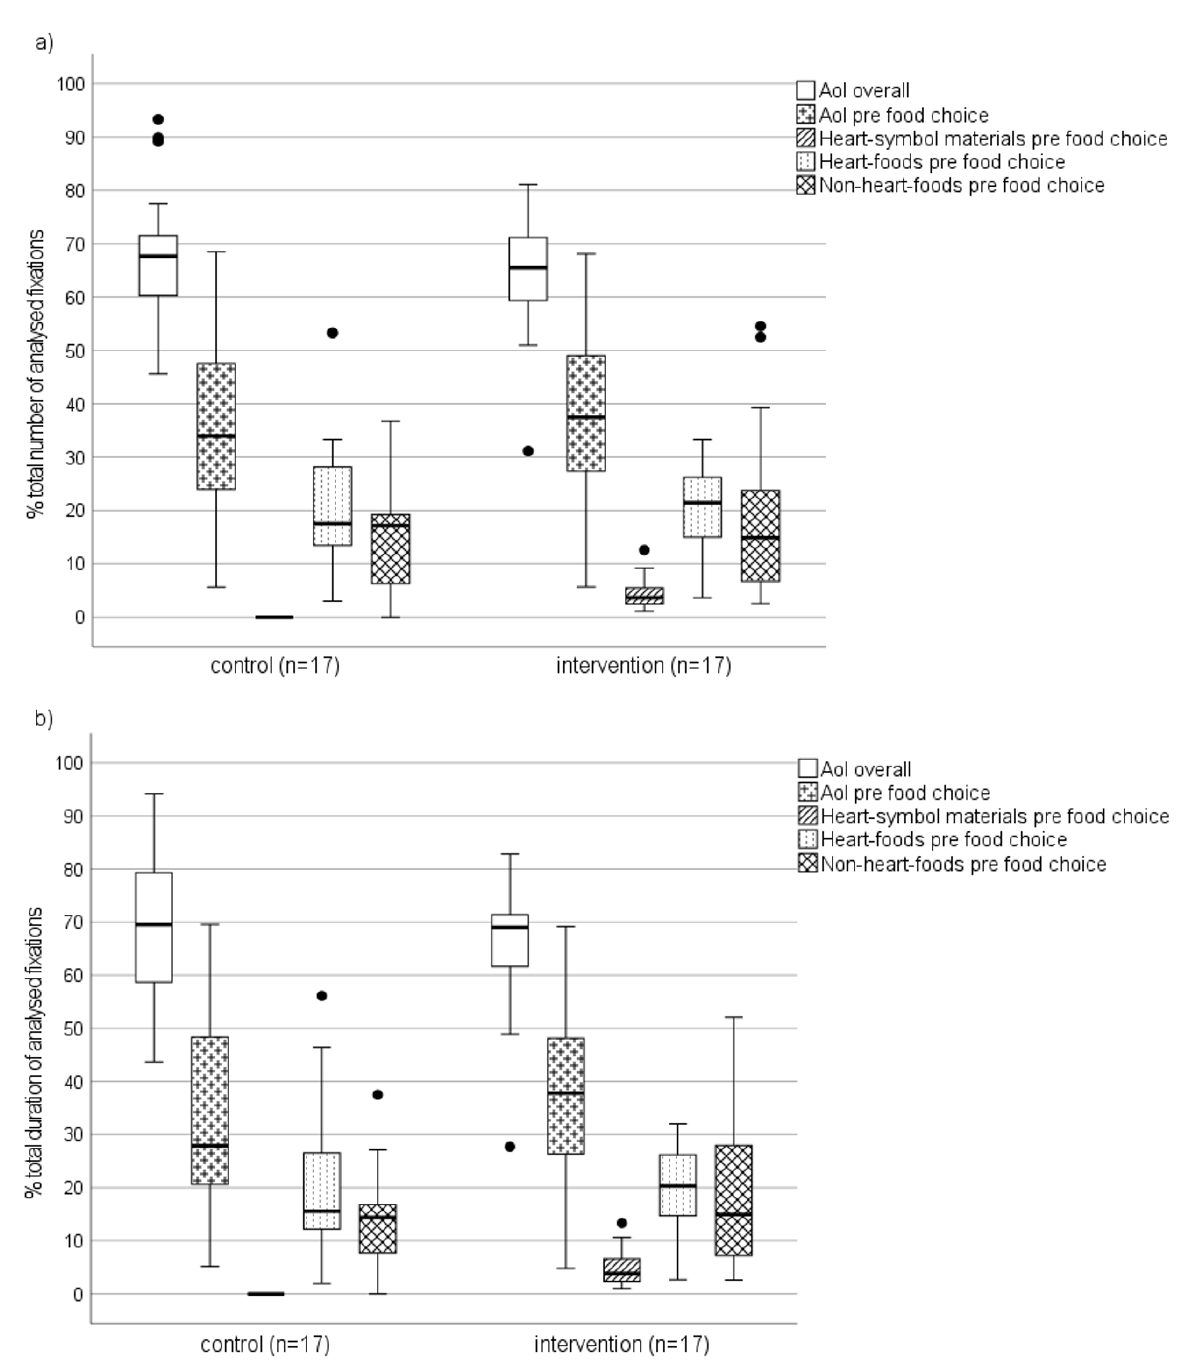
Figure 6. The distribution of ( a ) total number and ( b ) total duration of fixations on areas of interest (AoI, i.e., Heart-symbol materials, heart-foods, and/or non-heart-foods) as the percentages of total fixations accumulated at the analysed section of serving line stretch #2. Boxes extend from first to third quartile, horizontal lines across the boxes represent medians, whisker endpoints indicate minimum and maximum values, and dots represent outliers.